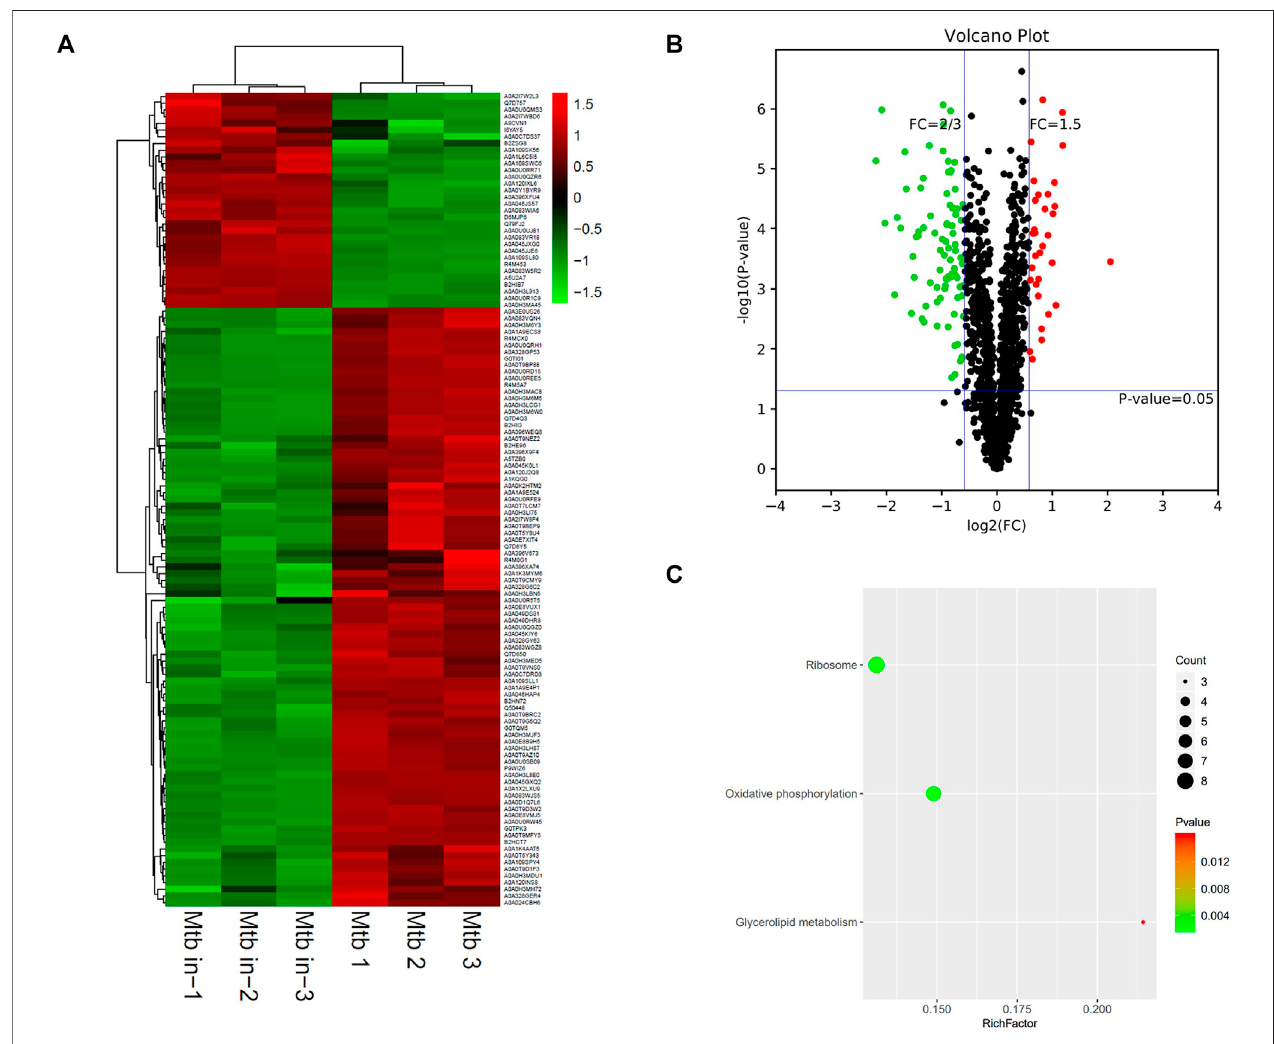
FIGURE 6 | Different protein pro fi le between intracellular M.tb and extracellular M.tb . (A) Heatmap of proteins differentially expressed between the group of intracellular M.tb and extracellular M.tb . Green-to-red scale indicates low-to-high proteins expression levels ( p < 0.05). (B) Volcano plots of proteins differentially expressed between the group of intracellular M.tb and extracellular M.tb . The red dots on the right indicate the signi fi cantly upregulated proteins, whereas the downregulatedareshown withgreen dotsontheleft. Differentiallyexpressed proteins werede fi ned based onathreshold foldchange > 1.5, at p < 0.05. (C) Top10 KEGG pathways (only three in this group) enriched for the signi fi cantly differentially expressed proteins. Entries with larger bubbles contain more differential genes. The color of the bubbles indicates the p value. The smaller the enrichment p value means the greater the degree of signi fi cance ( p <